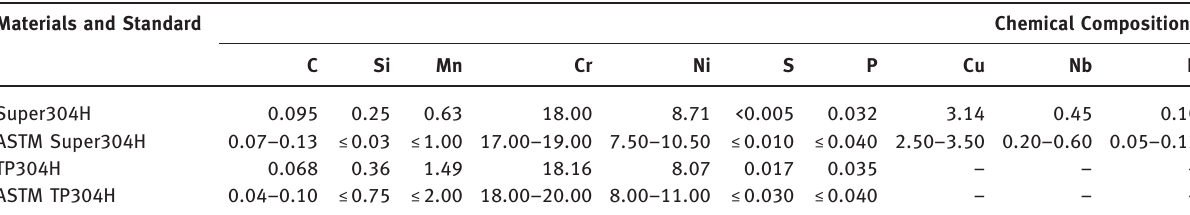
Table 1: Chemical compositions of Super304H and TP304H steels (mass%). Materials and